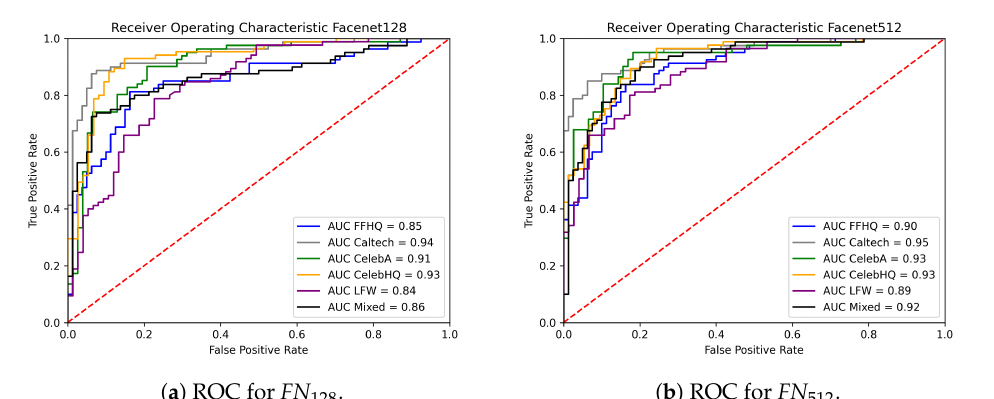
( a ) ROC for FN 128 . ( b ) ROC for FN 512 . Figure 12. Comparison of the ROC curves obtained with the SVM model using Facenet features.